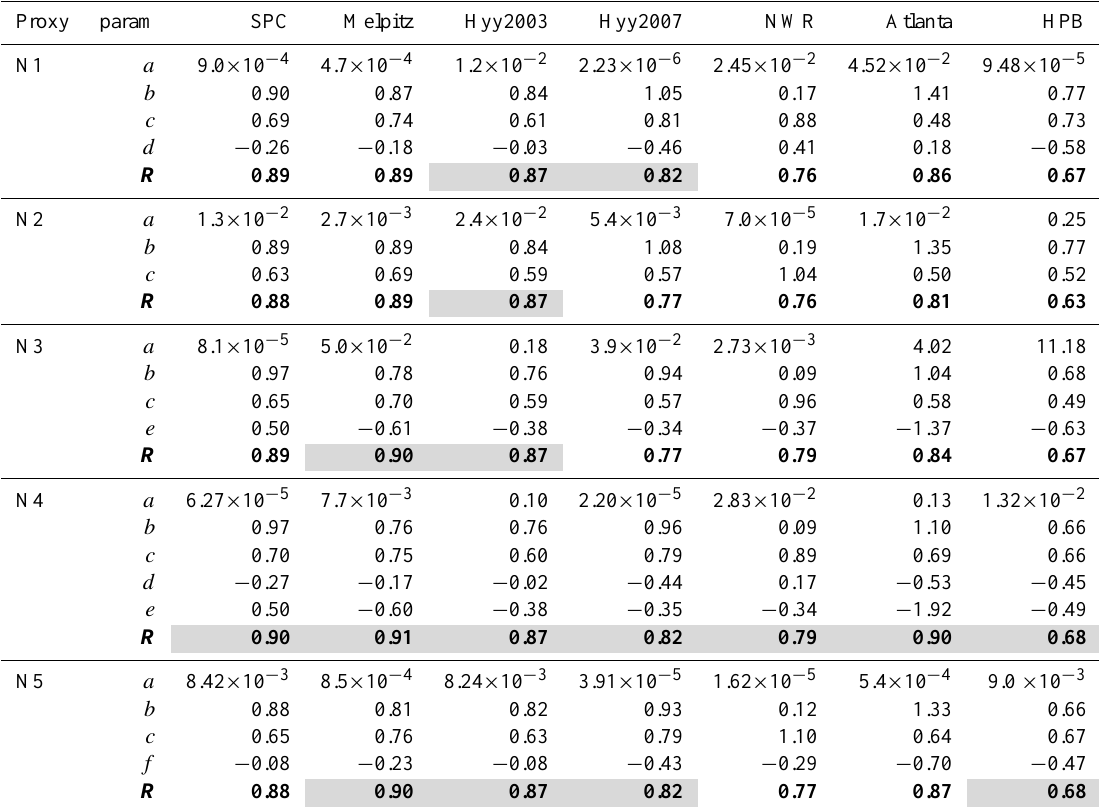
Table 6. Nonlinear fit results. Parameters a − f indicate the powers of proxy functions and R is the correlation between observed [H 2 SO 4 ] and the predicted values given by the proxy. Best correlations for each site are highlighted.